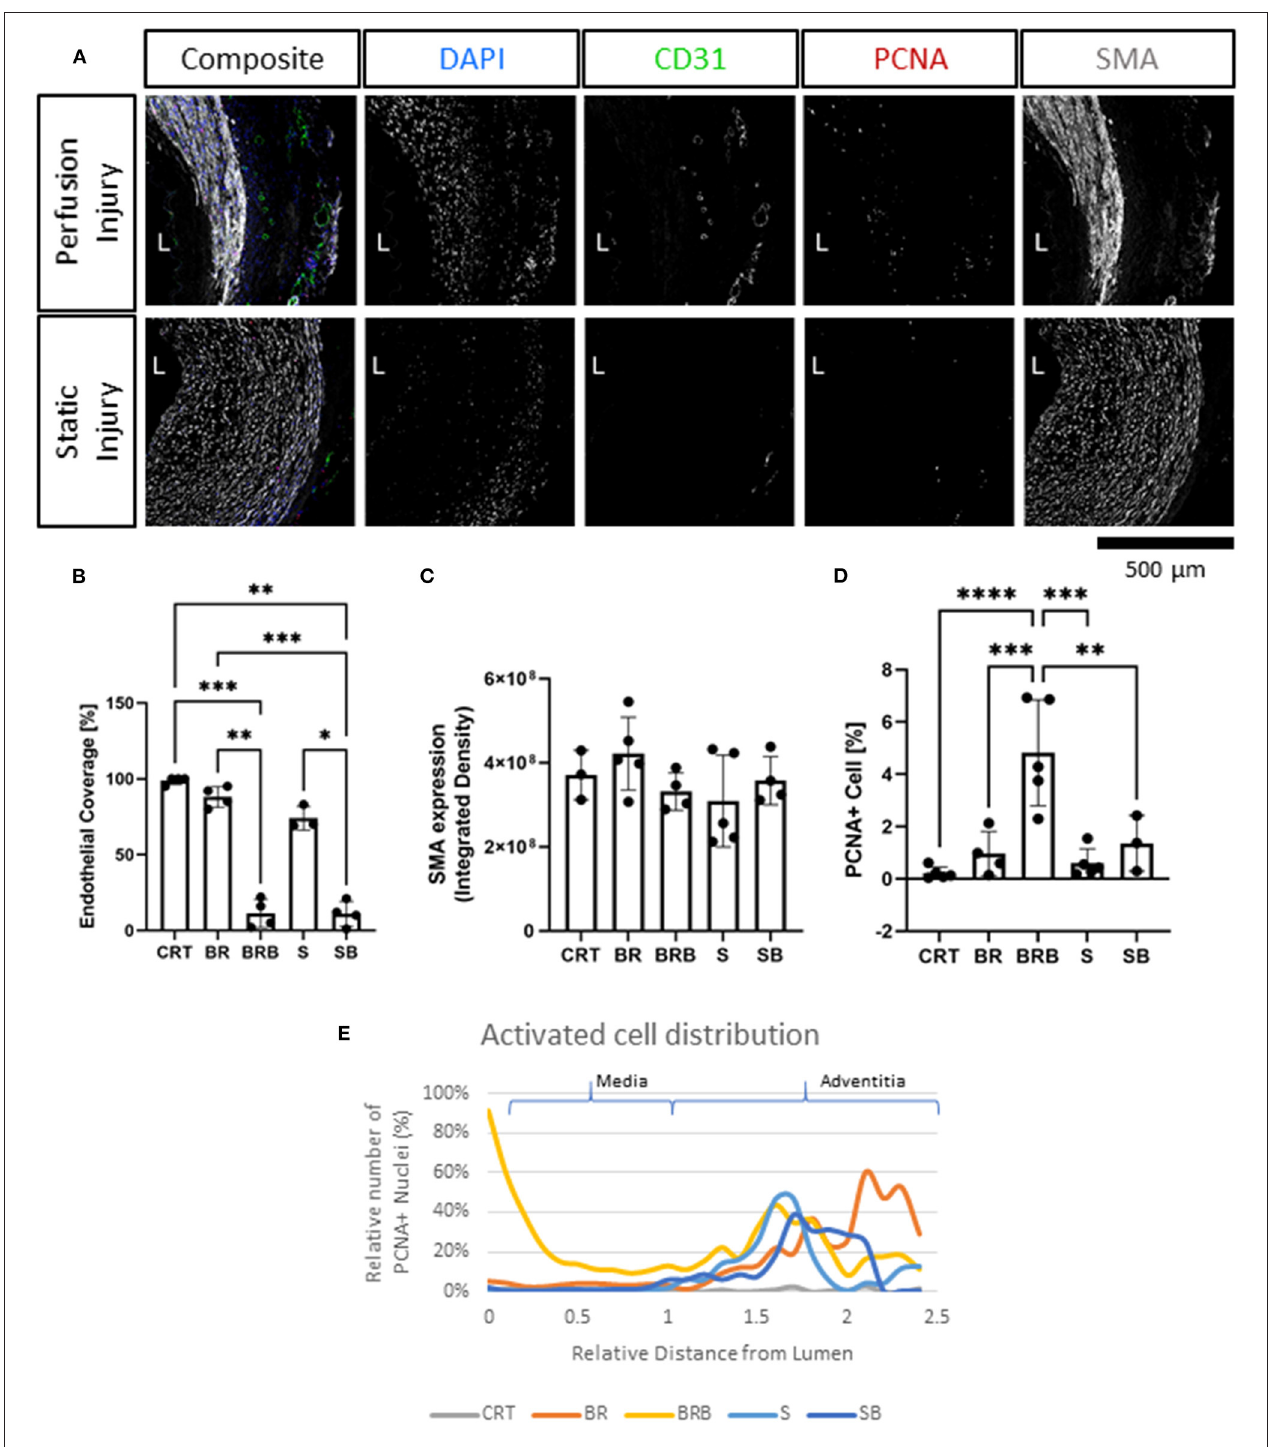
FIGURE 6 | Immunofluorescence evaluation reveals tissue injury and activation following balloon angioplasty and culture in flow. Following injury, tissues were cultured for 7 days in either perfusion (Perfusion Injury) of static conditions (Static Injury) and then stained for the endothelial marker (CD31), smooth muscle marker (smooth muscle actin, SMA), and proliferation marker (proliferating cell nuclear antigen, PCNA). Nuclei are stained with DAPI. Representative confocal images are displayed in composites and by individual marker in montage (A) . Lumen is identified (L), Scalebar = 500 µ m. Quantifications of lumen coverage (B) , SMA intensity (C) , and proliferation PCNA (D) are displayed in the bar graphs, n = 3–5. All data are mean ± SD. One-Way ANOVA analysis was performed, * p ≤ 0.05, ** p ≤ 0.01, *** p ≤ 0.001, **** p ≤ 0.0001. Distribution of proliferating cells (PCNA + ) in relation to their relative distance to the lumen is plotted for freshly isolated arteries (CRT), healthy and injured arteries cultured in EasyFlow (BR and BRB, respectively) or static conditions (S and SB, respectively) (E) .